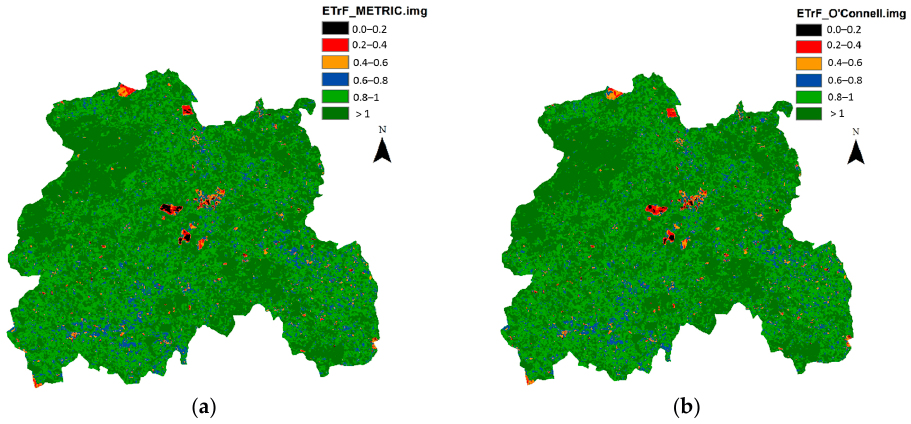
Figure 3. ET r F maps, 17 July 2006: ( a ) METRIC based; and ( b ) O’Connell based.